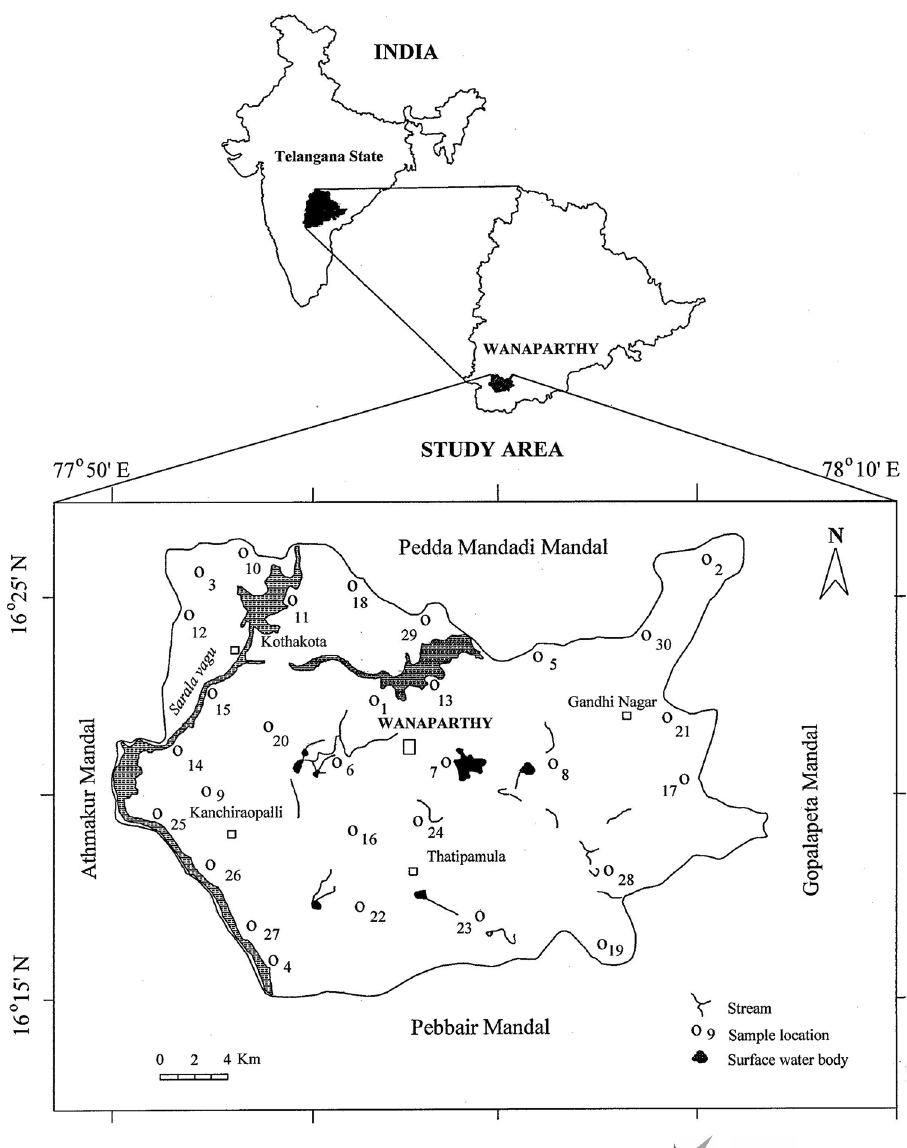
Fig. 1 Location of the